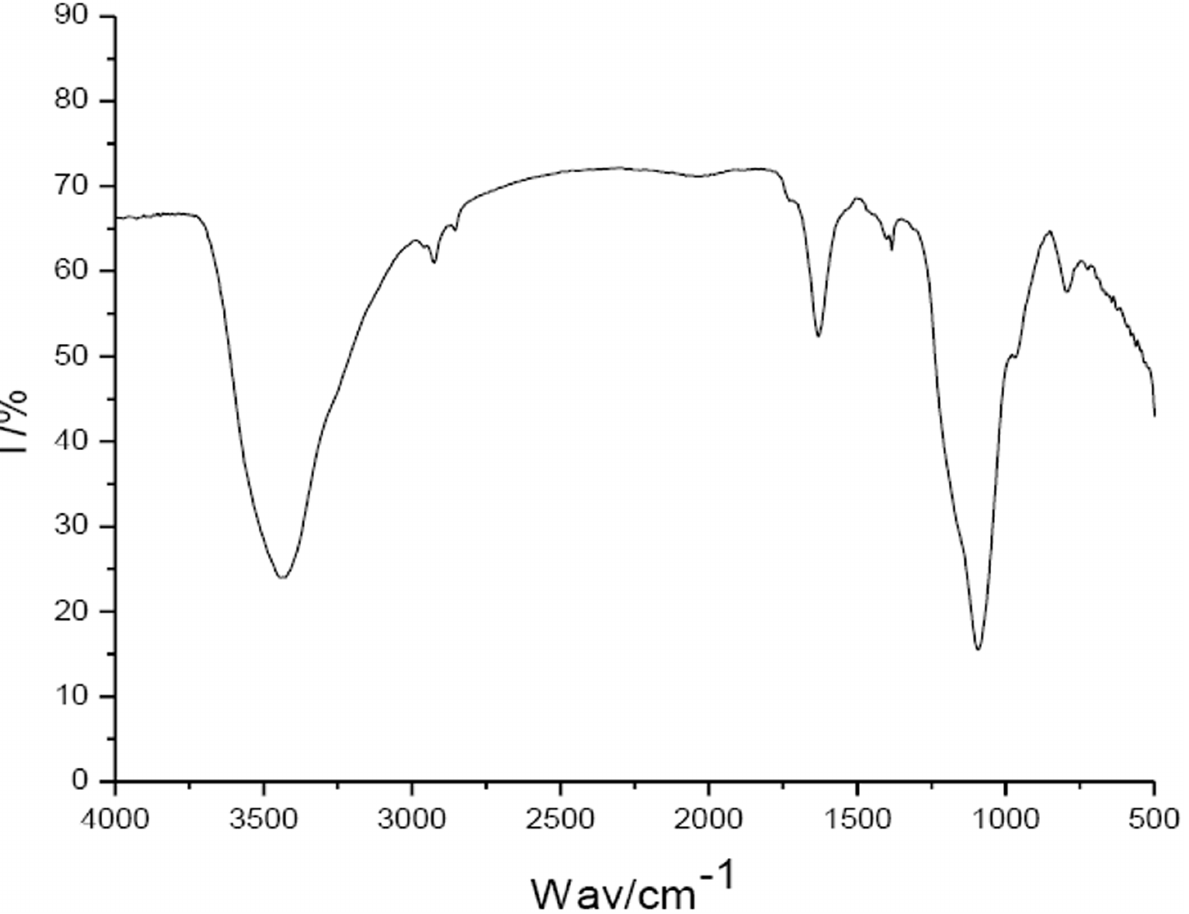
Fig 4. IR scanning spectra of the pigment extracted from the adductor muscle scar of Pacific oyster. ‘ T ’ denotes the transmittance, ‘ Wav ’ the